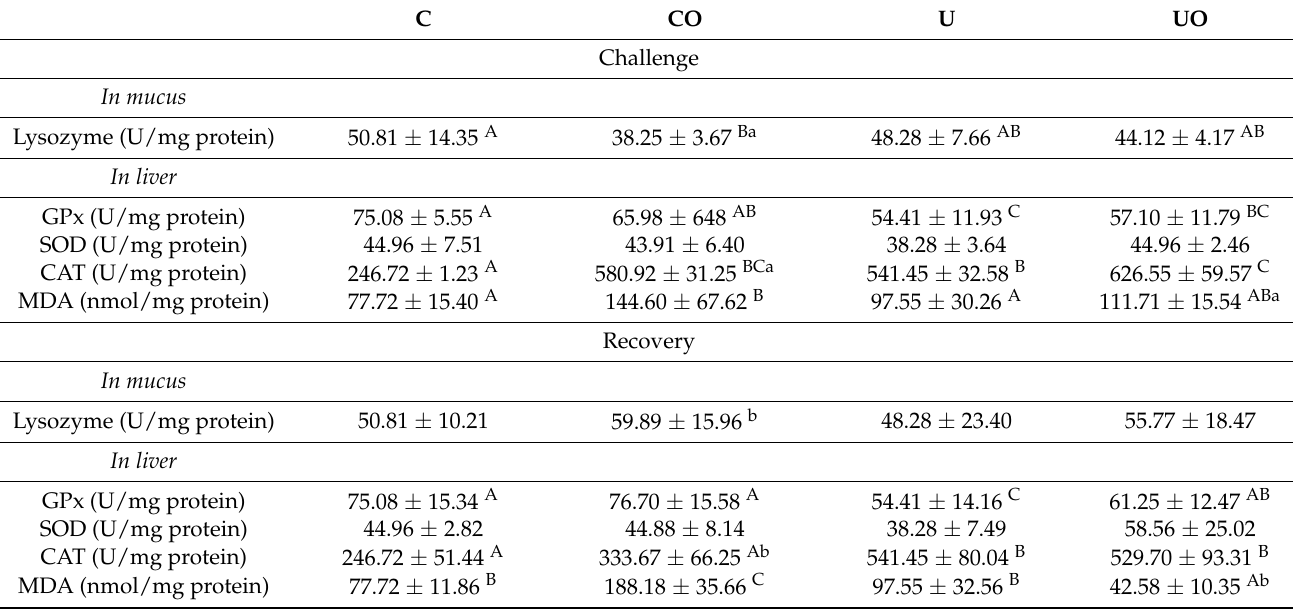
Table 8. Experiment 3. Immunological and oxidative status measured in mucus and liver as a response to oxidation associated with the consumption of a feed enriched with macroalgae. Comparisons of enzyme activities between feeds within each stage (challenge/recovery) are indicated with capital letters, while those made between each feeding phase for the same diet are detailed with a small letter. Values presented as mean ± SD. Values not sharing the same superscript differ significantly with p <